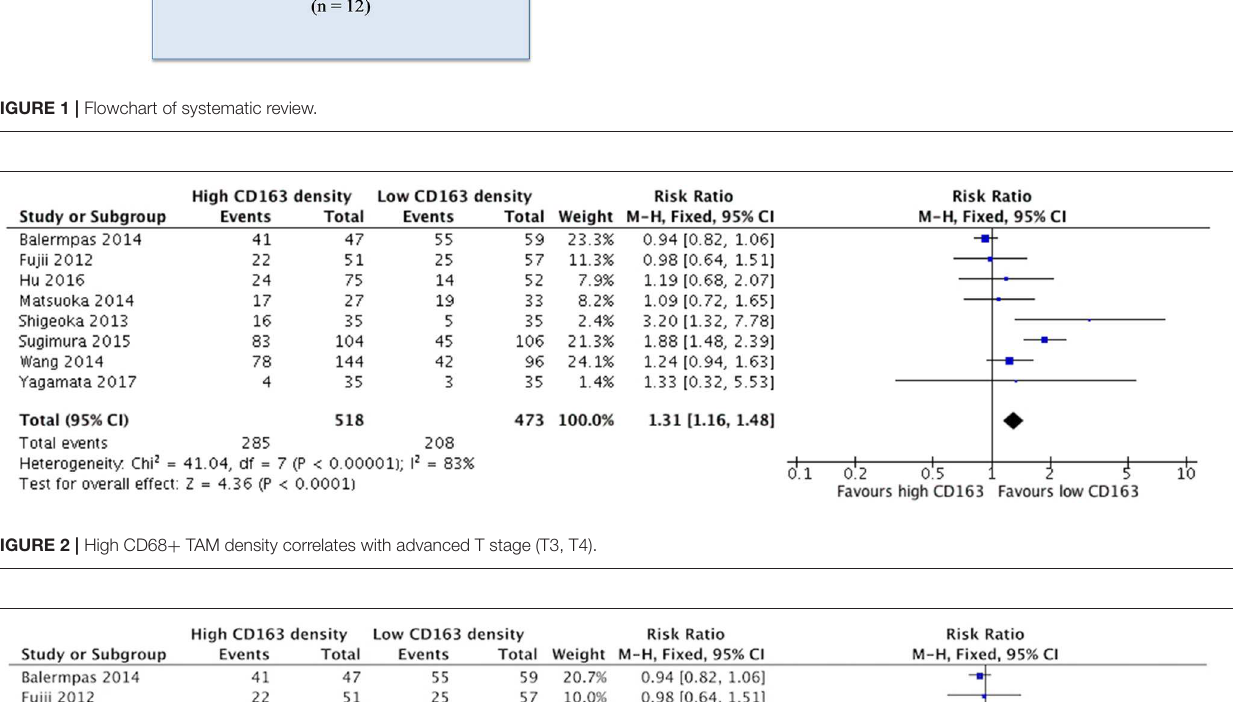
invasion, vascular invasion. After identification, screening, and evaluation of eligibility, 12 studies were selected for meta-analysis